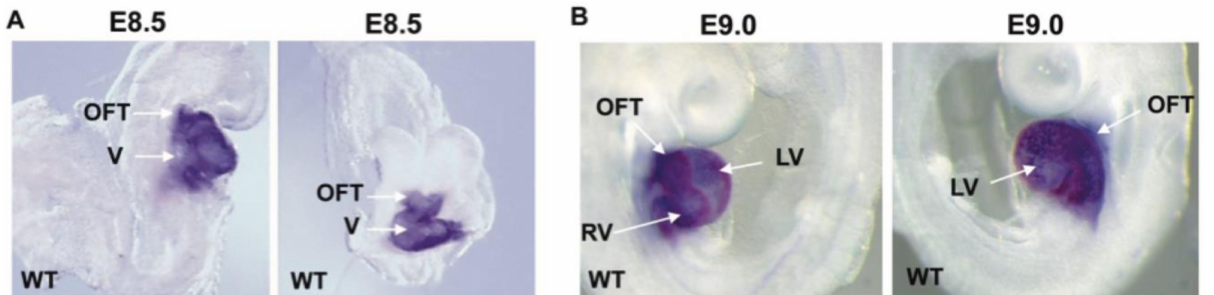
Figure 3. The expression of SMYD1 in wild type (WT) mouse embryos. ( A , B ) shows whole-mount in situ hybridization shows the expression of SMYD1 in the ventricle (V), left ventricle (LV), right ventricle (RV), and outflow tract (OFT) of a mouse embryo heart at E8.5 and E9.0. Image licensed under CC-BY 4.0; Ref. [17].